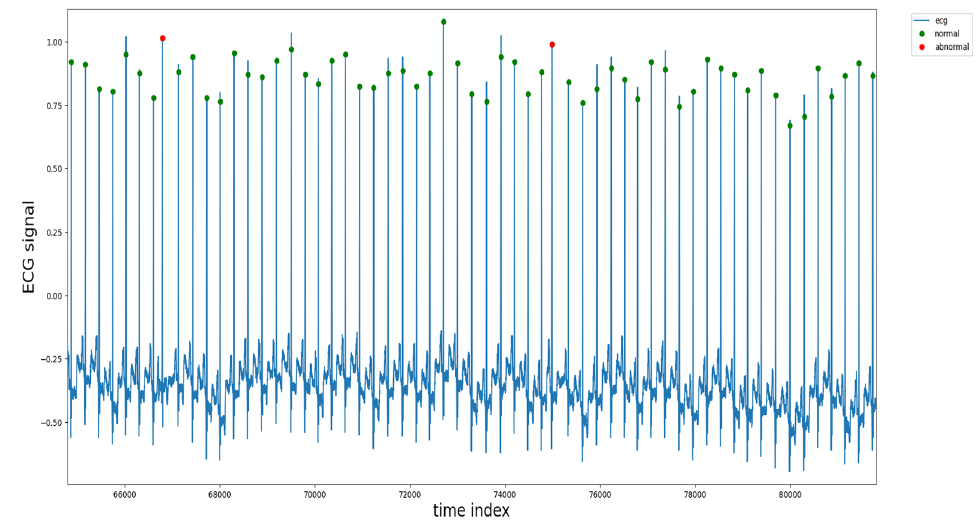
Figure 1. Annotations of heartbeats in the